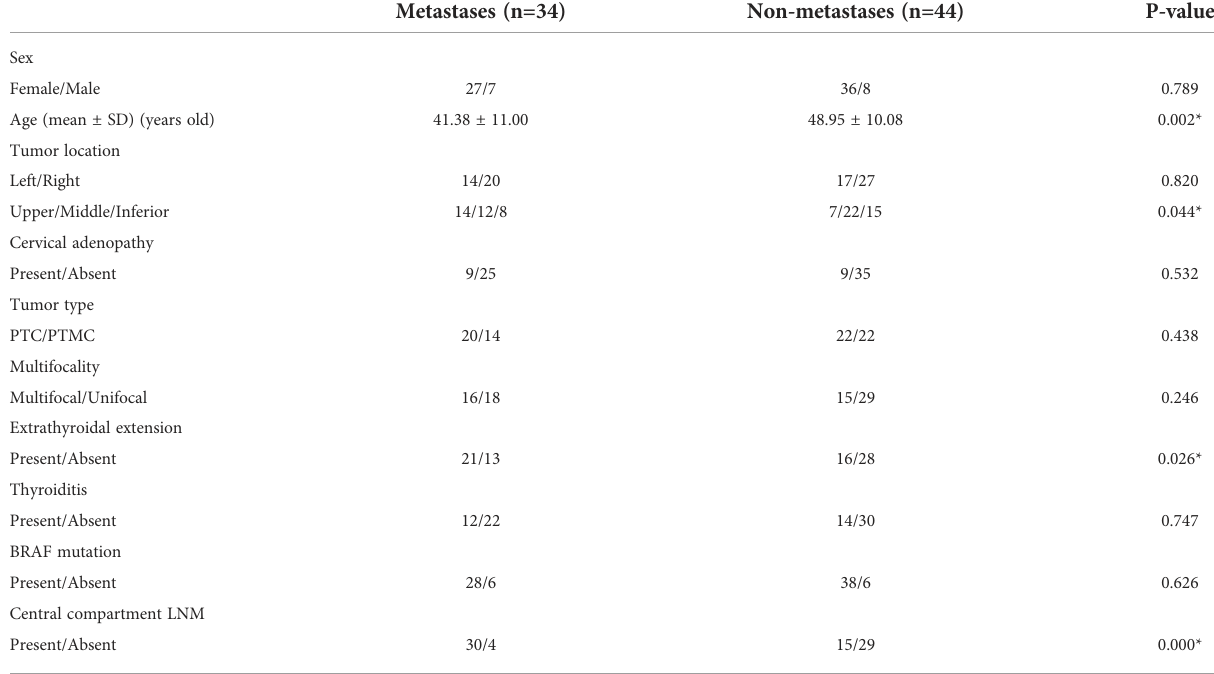
TABLE 3 Comparison of patients with and without LNM in the lateral compartment (n = 78).